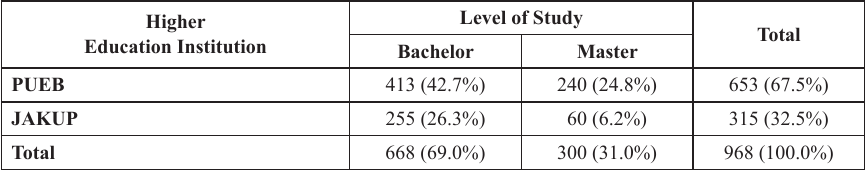
Table 1. Structure of the research sample – level of study